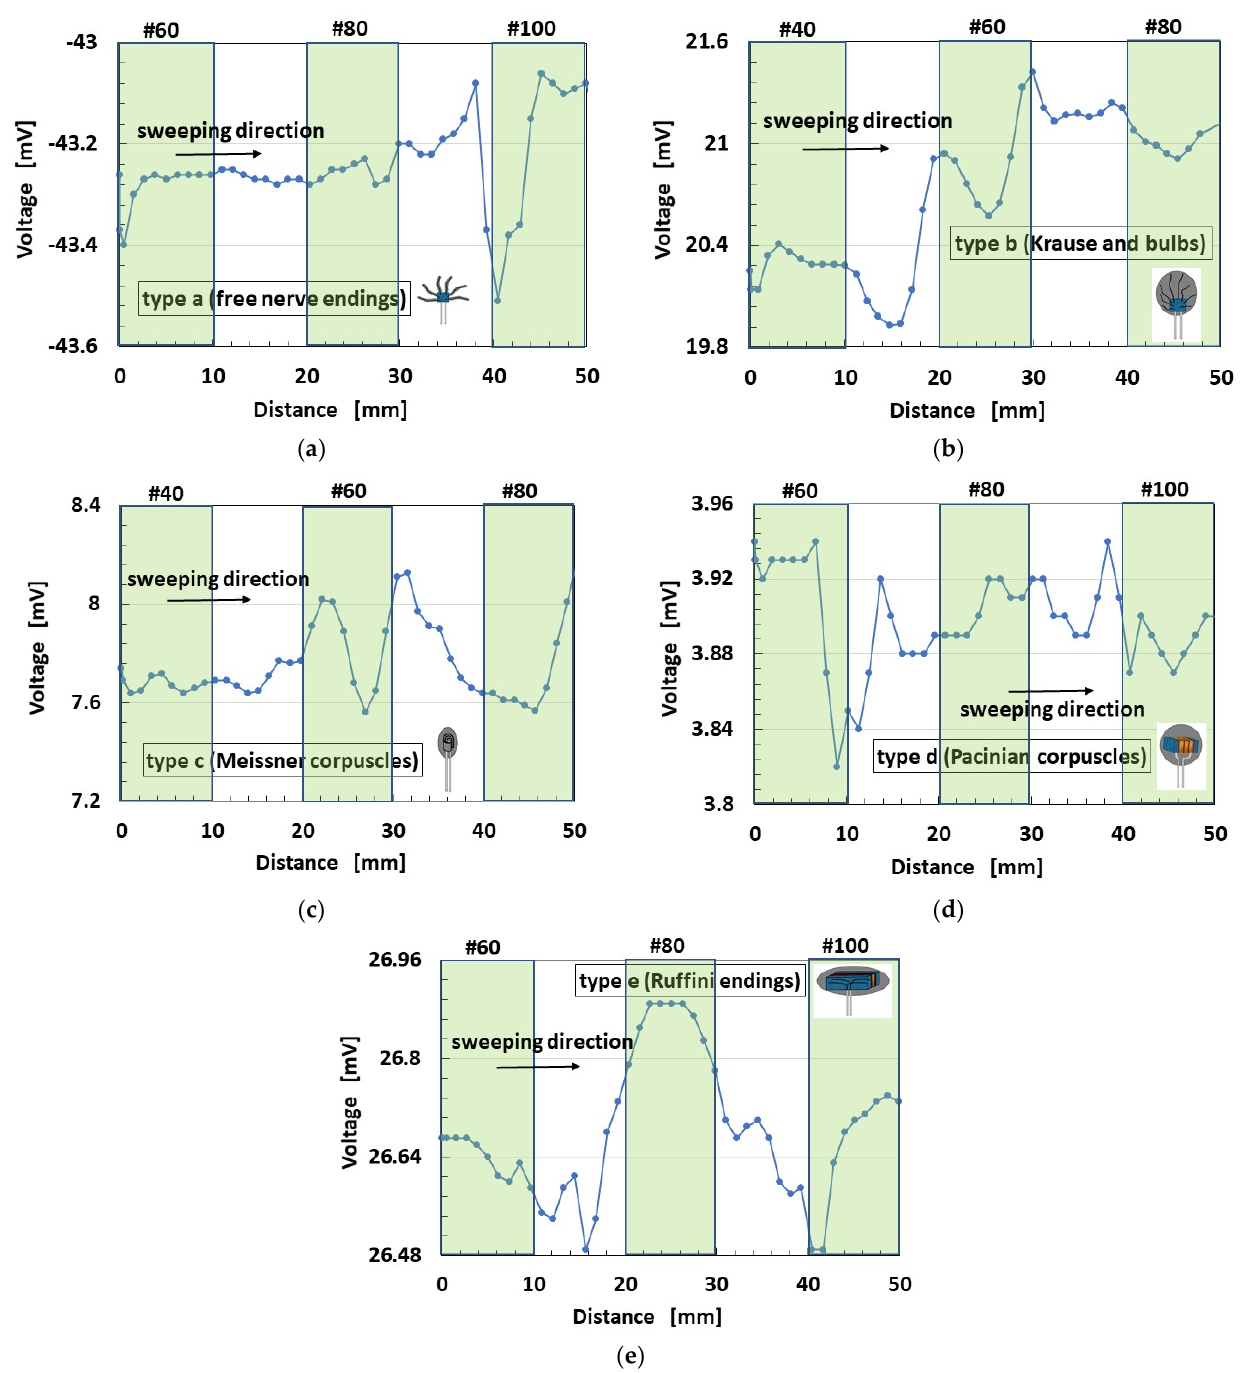
Figure 18. Voltage of each of the cutaneous receptors at shear motion on a body with alternate surface roughness: ( a ) Type A; ( b ) Type B; ( c ) Type C; ( d ) Type D; ( e ) Type E.